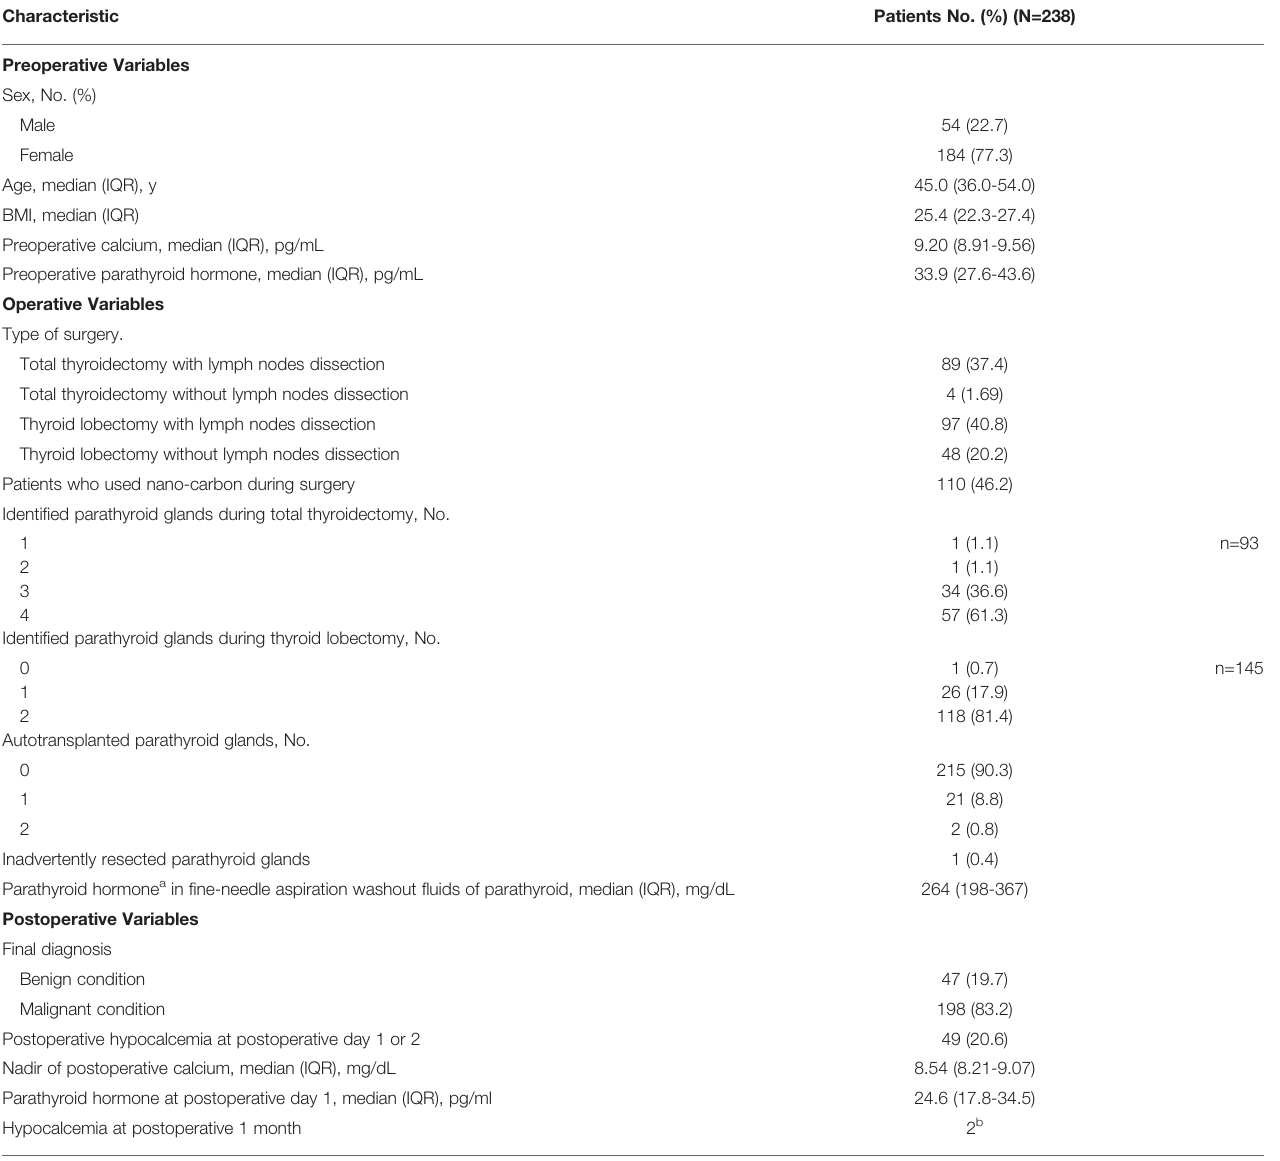
TABLE 1 | Clinical Characteristic of Participants.